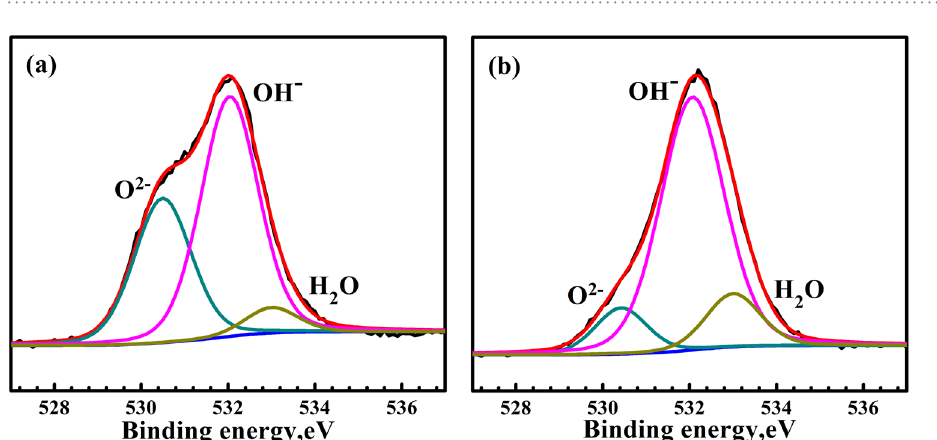
Figure 4. XPS spectra of O 1 s of the passive films formed on the uncharged surface ( a ) and hydrogen-charged surface ( b